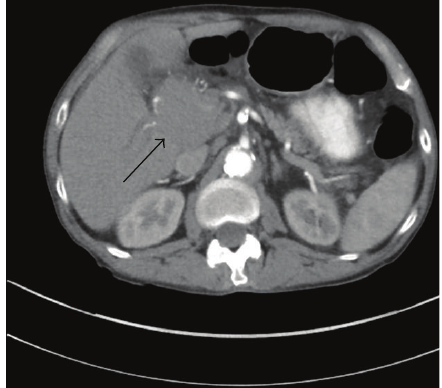
Figure 1: Case 1—MRI abdomen pelvis revealed 5.5 × 5.4 × 4.9 cm mass and biliary ductal dilatation from extrinsic compression (black arrow).